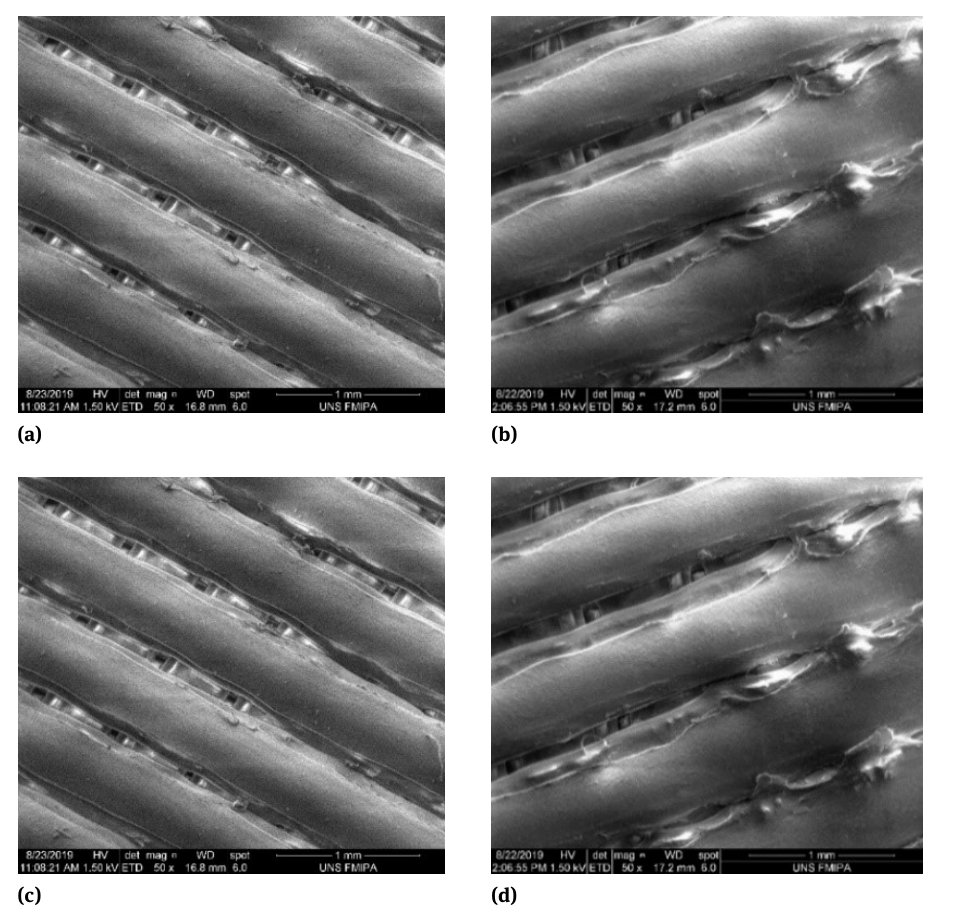
Figure 4: SEM images of the specimen created by nozzle with diameter of (a) 0.3 mm, (b) 0.4 mm, (c) 0.5 mm, (d) 0.6 mm